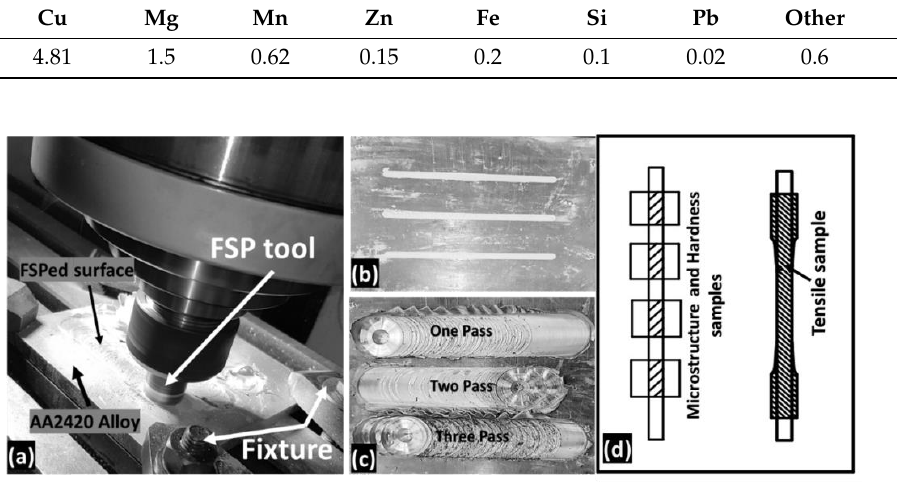
Figure 1. ( a ) Friction stir processing using milling machine, ( b ) the preparation of the AA2024 sheet filled with Al 2 O 3 nanoparticles, and ( c ) composite surface with different FSP passes. ( d ) The orientation of the tensile, hardness, and microstructure samples.